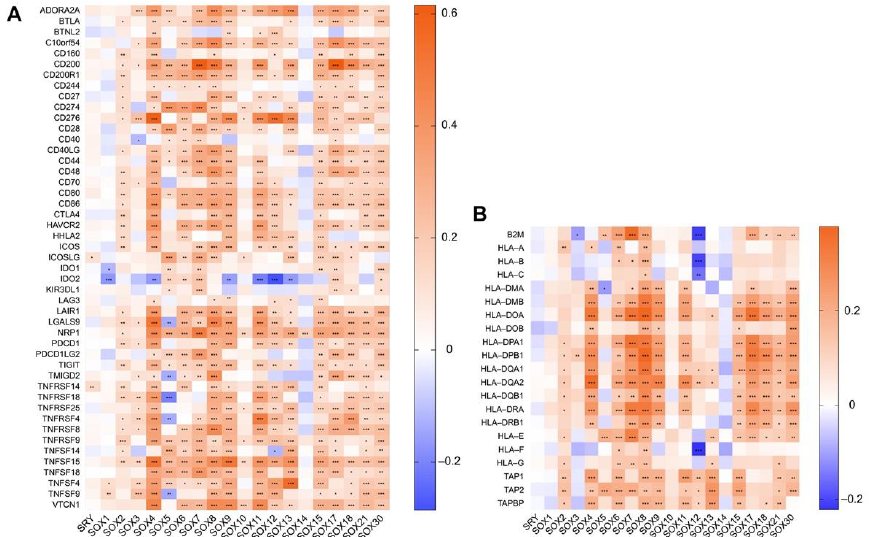
Figure 4. Correlation between the expression of SOX transcription factors and that of immune-related genes in hepatocellular carcinoma. ( A ) The relationships between SOX factors expression and the levels of immune checkpoints genes and ( B ) antigen-presenting molecules were analyzed by the TIMER2. Red indicates positive correlation and blue indicates negative correlation. The darker the color, the stronger the correlation. * p < 0.05, ** p < 0.01, *** p < 0.001.